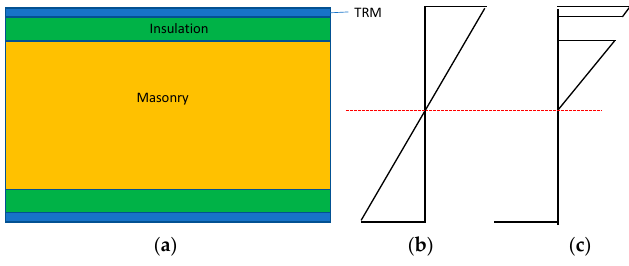
Figure 9. ( a ) Cross-section, ( b ) strain profile, and ( c ) stress profile.